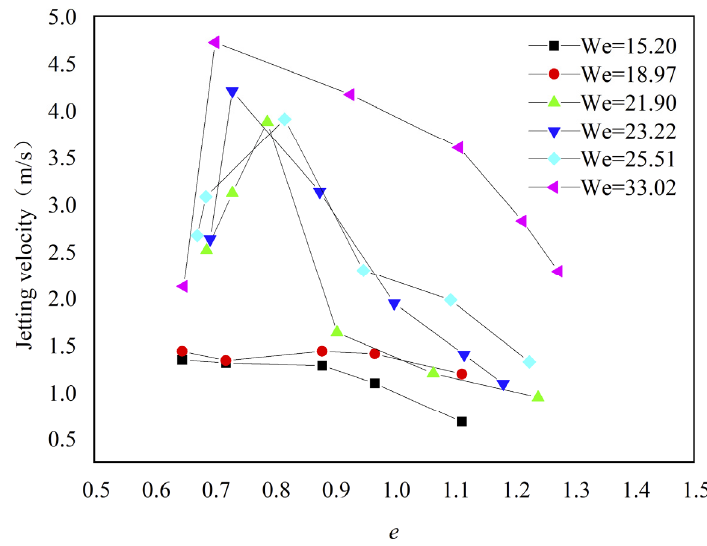
Figure 3. The jetting velocity under different conditions.